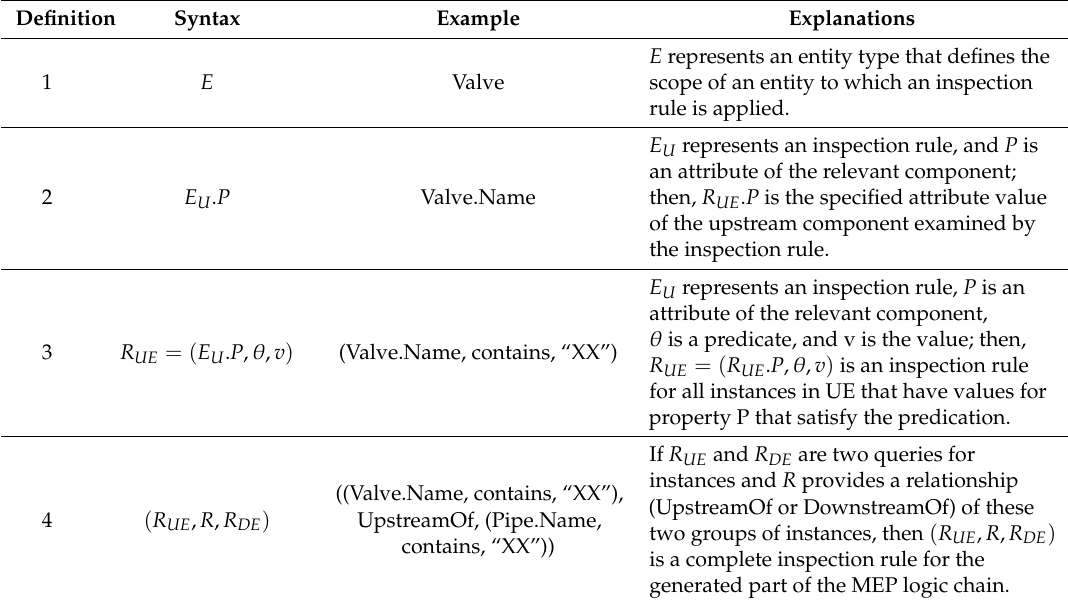
Table 3. Description and examples of the syntax.